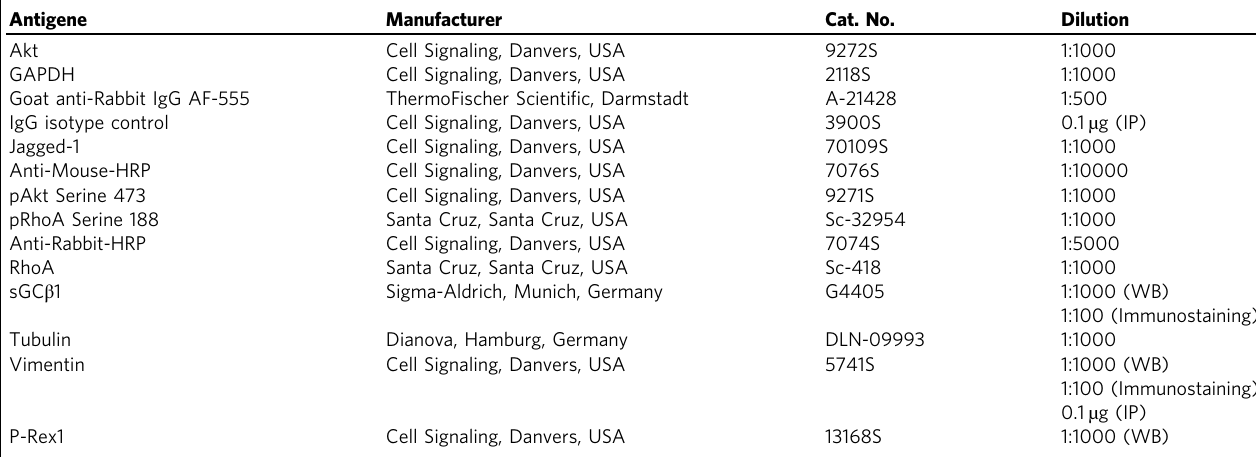
Table 1 List of antibodies used in this study. Antigene